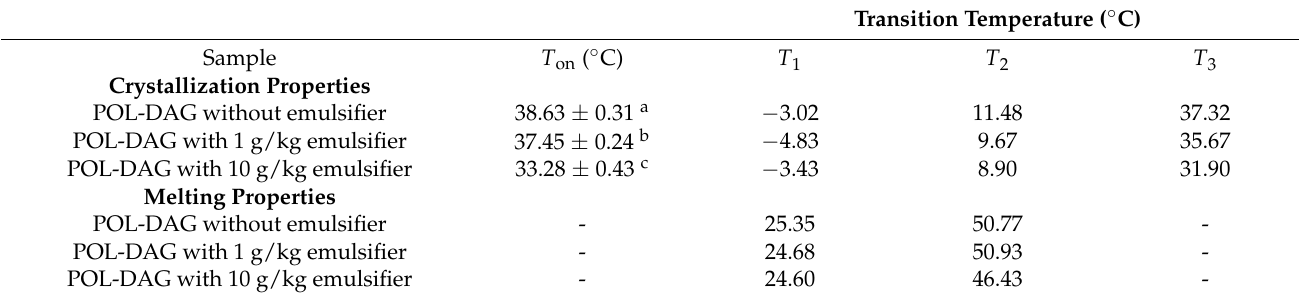
Table 1. Dynamic crystallization and melting parameters of palm olein-based diacylglycerol (POL-DAG) oil with and without emulsifier (scanned at 5 ◦ C min − 1